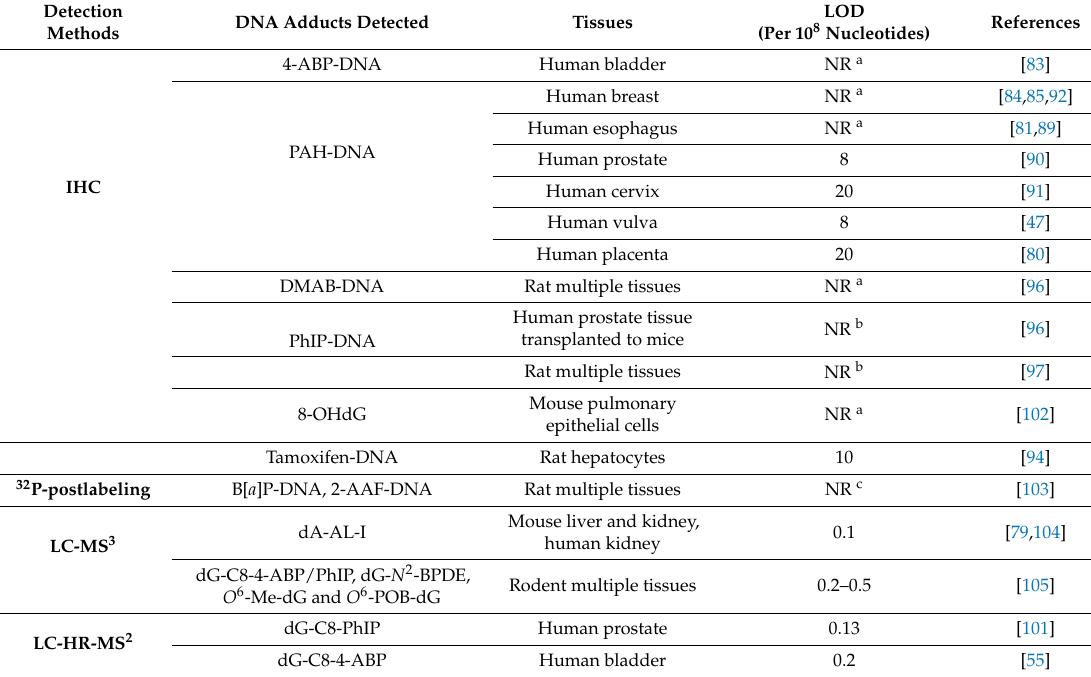
Table 1. Examples of DNA adducts detected in FFPE